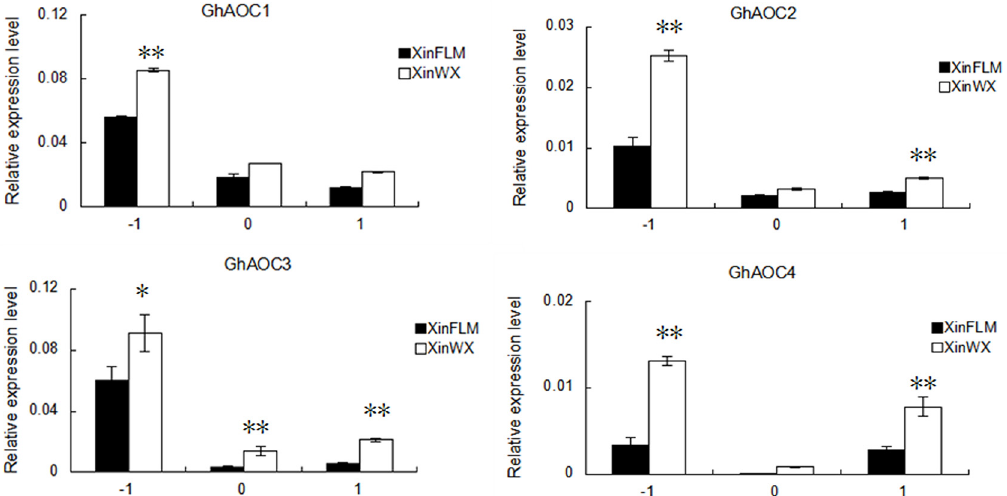
Fig 4. Comparison of AOCs expression in XinWX and XinFLM. Ovules at -1, 0 and 1 DPA are shown. Significant differences at the 0.05 and 0.01 probability levels are represented by * and ** , respectively. Error bars indicate ± SD. The expression level was derived from triplicate experiments. Three biological replicates were used for